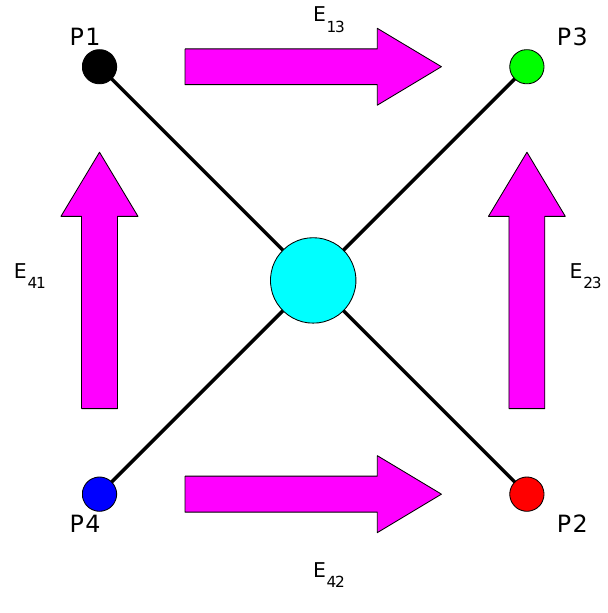
Fig. 1. The configuration of the EFW electric field